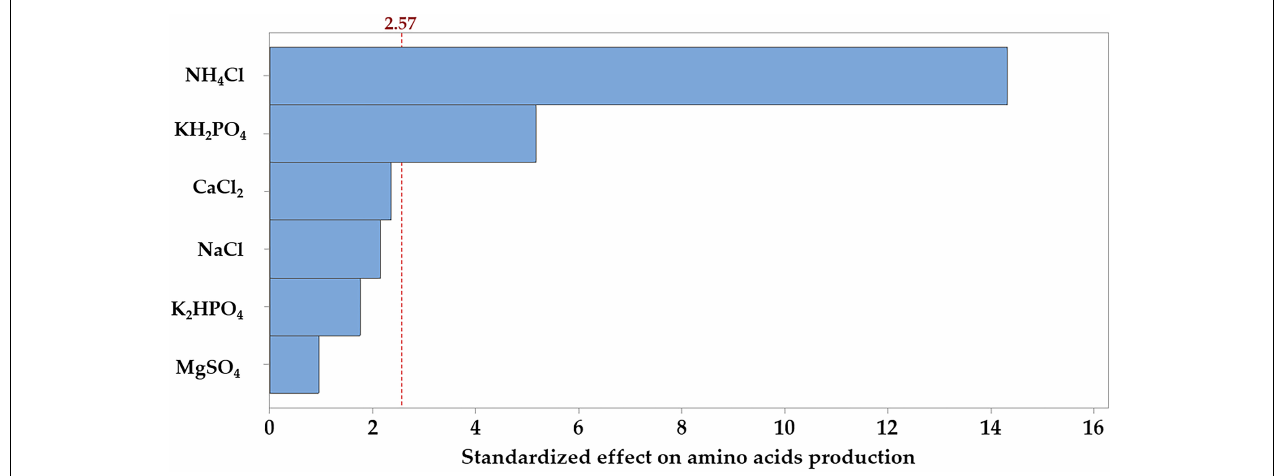
FIGURE 4 | Pareto chart, displaying the standardized effects of each of the tested salts on the production of the amino acids by B. paramycoides ZW-5.